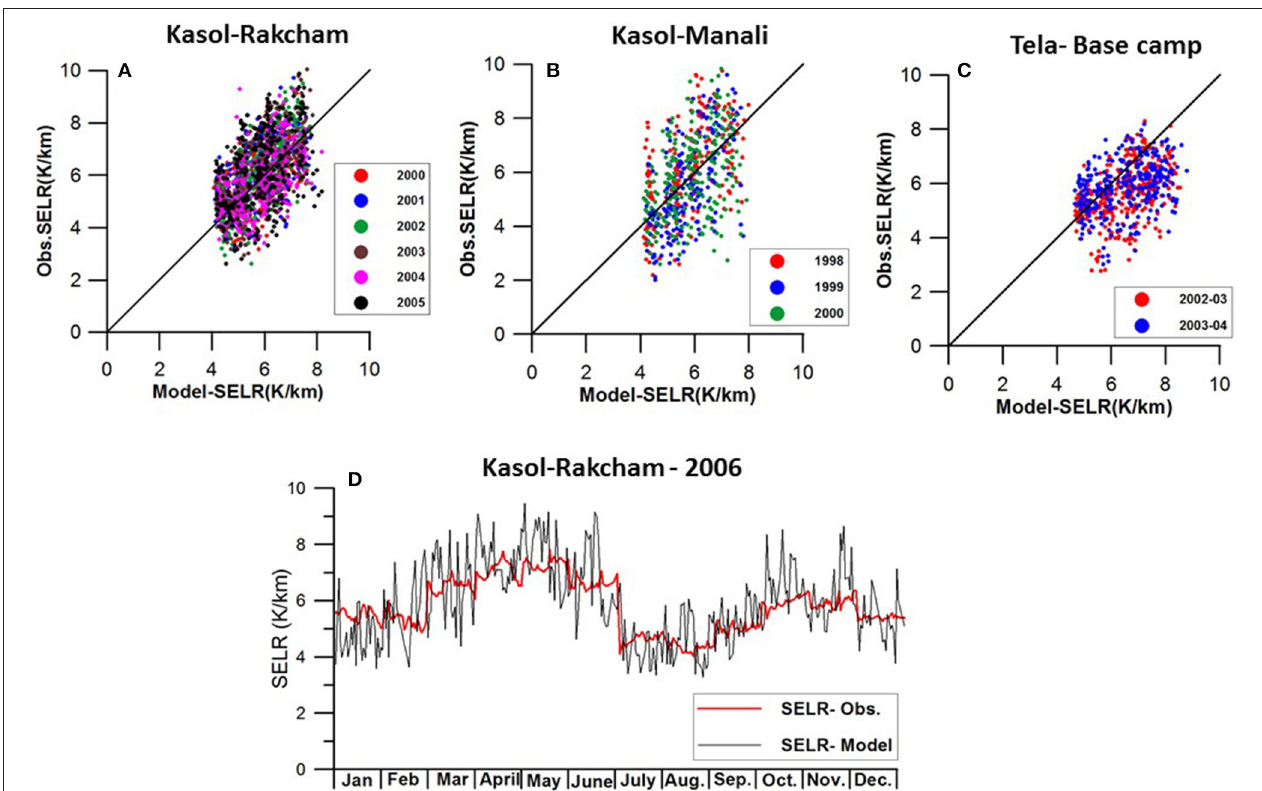
FIGURE 8 | Testing of monthly SELR indices for daily lapse rate assessment of (A) Kasol–Rakcham and (B) Kasol–Manali section in the Sutlej–Beas basin and for (C) Tela–Basecamp section in the upper Ganga basin. Model has been sucessful in estimating the temporal mean lapse rates but not suceeded in capturing the day to day SELR variations (D)